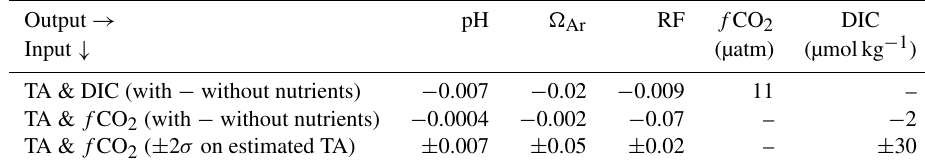
Table 5. Errors associated with calculating carbonate system parameters in the absence of nutrient data and when using salinity-based estimates of TA for marine surface waters near Washington. Results for the TA–DIC and TA– f CO 2 pairs of input parameters are